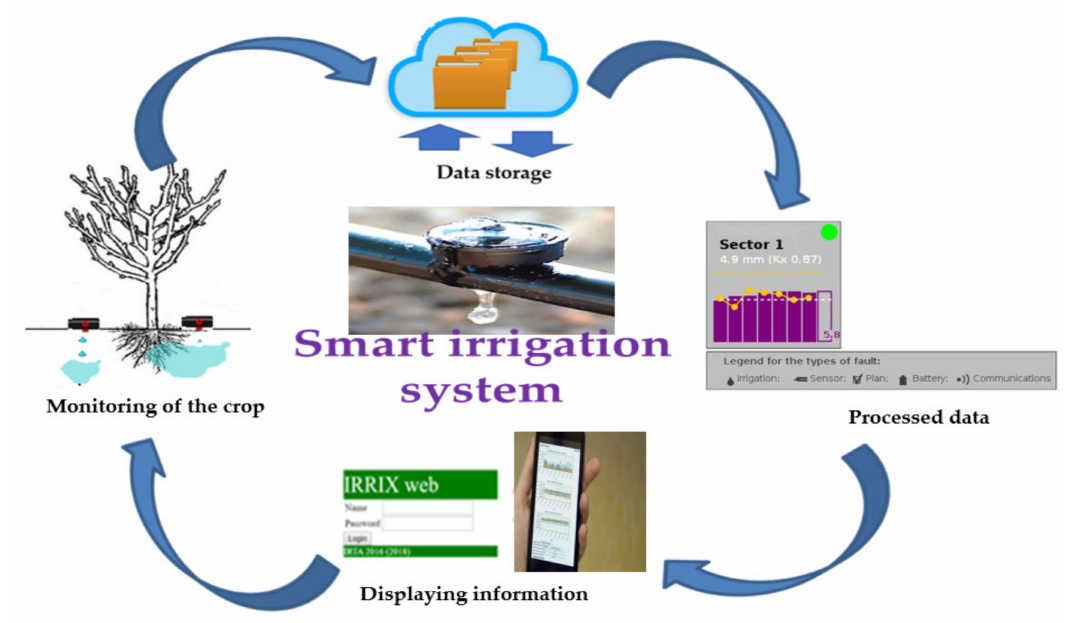
Figure 3. Tasks carried out by